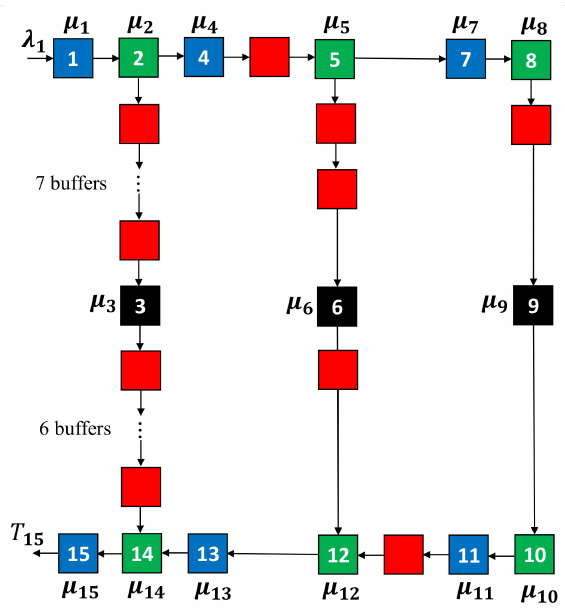
Figure 14. Production line topology after bu ff ers are allocated by API-VNS in the case of λ = 0.6 in experiment 1.